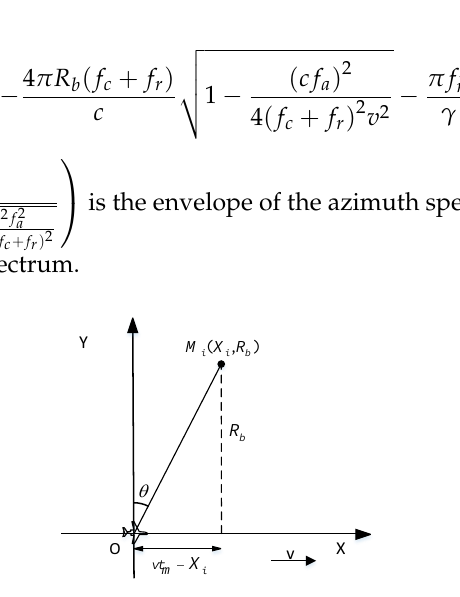
Figure 4. Single beam signal model.